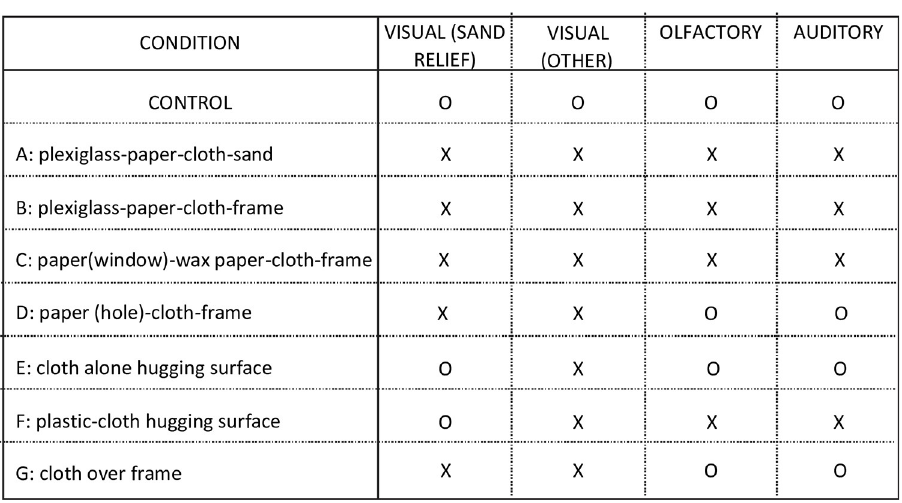
Fig 1. Table 1. Cues affected by different layers of materials covering the nest entrance. Layers of different materials as indicated under CONDITION were placed over the nest entrances of wasps which left visual, olfactory or auditory cues masked (X) or unmasked (O).